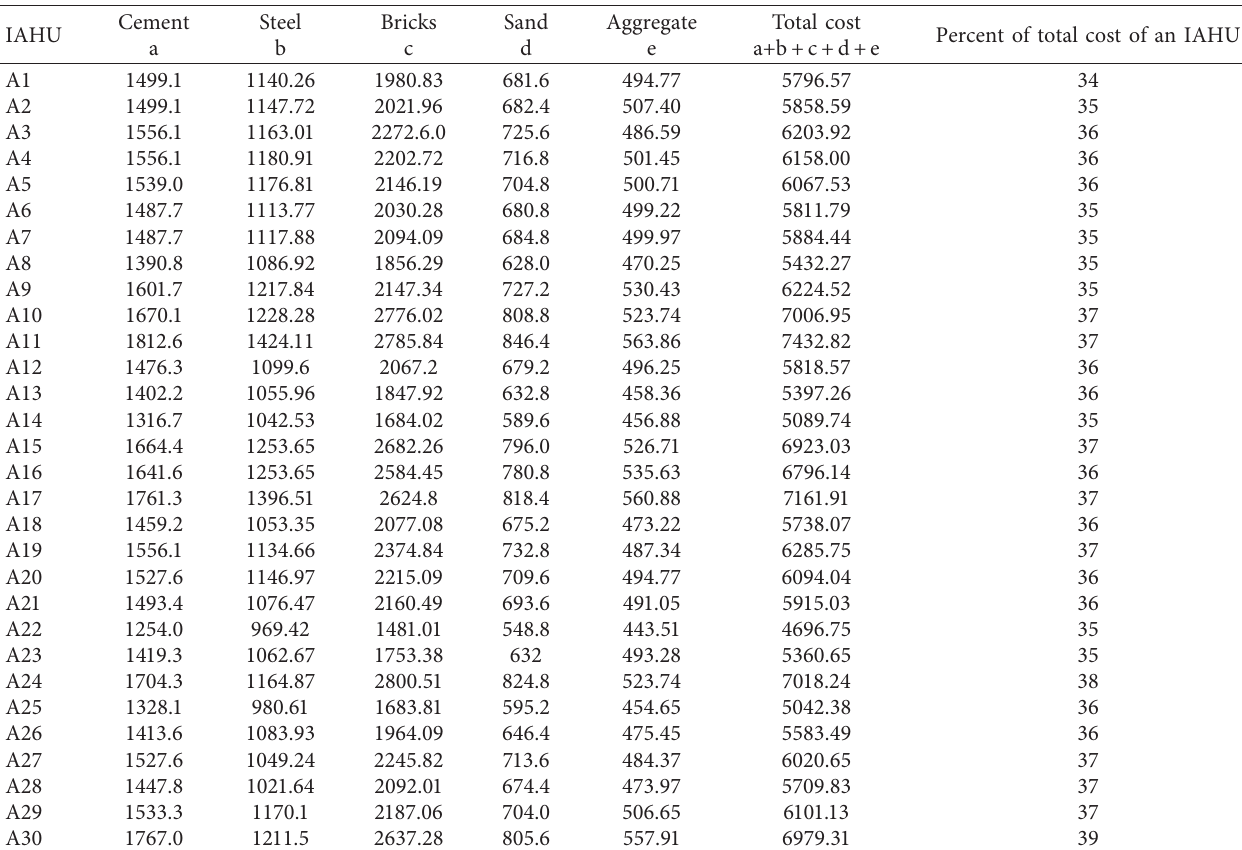
Table 6: Cost of major construction materials for selected 30 IAHUs in